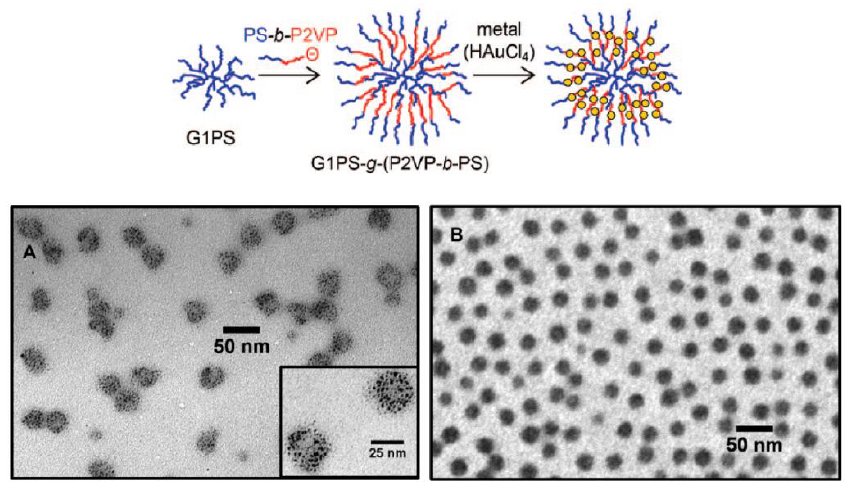
Figure 7. Top: Schematic representation of the synthesis of a core-shell-corona arborescent copolymer structure by grafting “living” block copolymer chains onto an arborescent polystyrene substrate. Bottom: Examples of TEM micrographs obtained for G2 (A) and G0 (B) templates loaded with HAuCl at 0.25 and 0.50 equiv relative to 2VP 4 residues, respectively. Adapted from Reference 33 by permission from the American Chemical